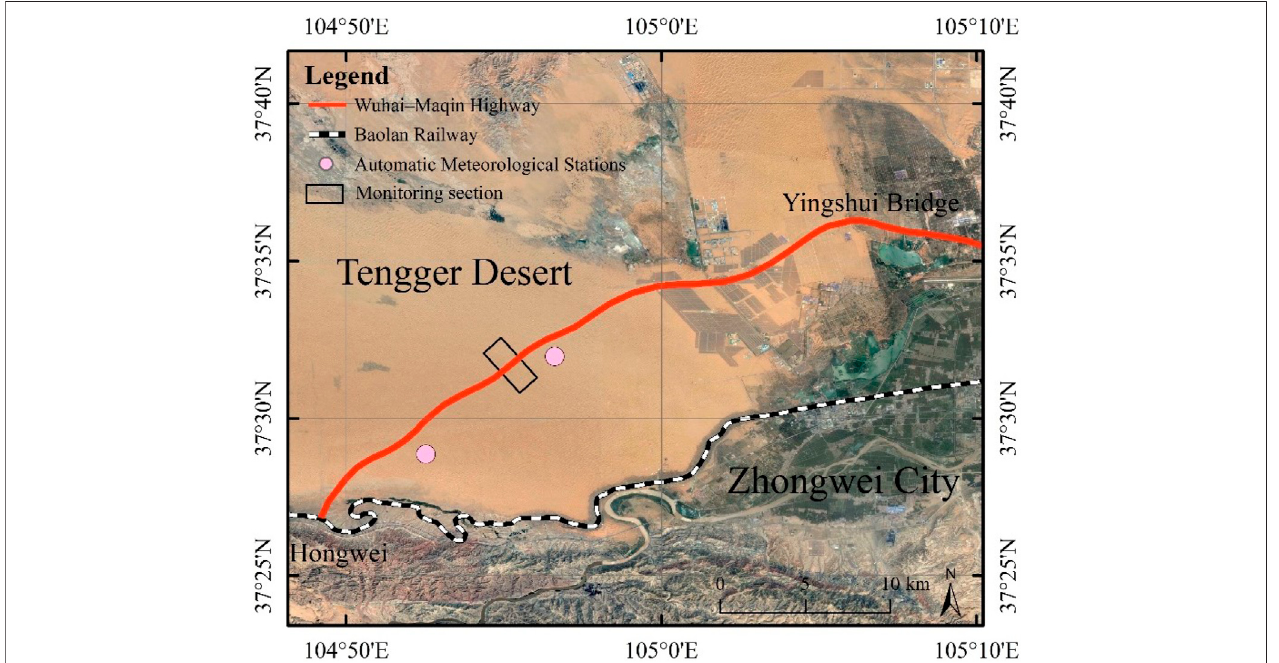
FIGURE 2 | Location of observation instruments on the Tengger Desert section of the Wuhai – Maqin Highway.